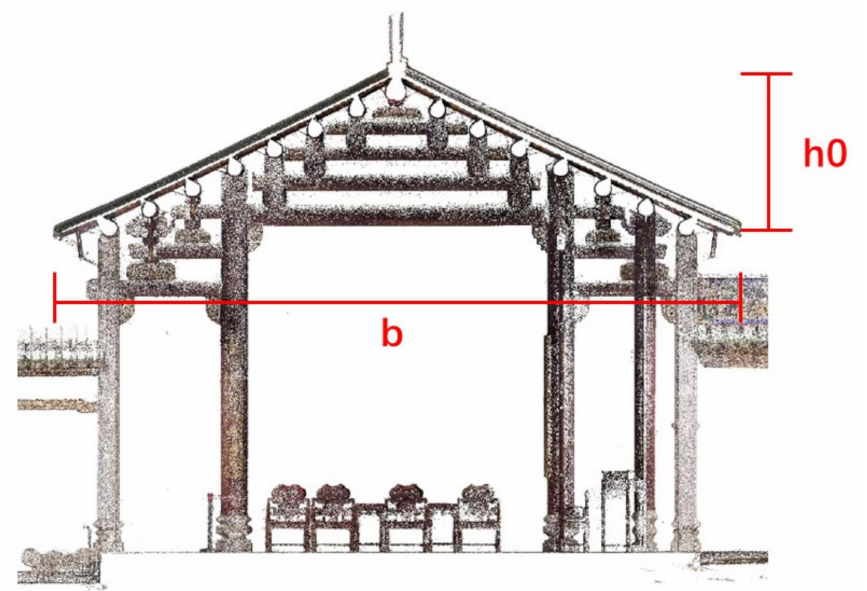
Figure 11. Method of measurement. b: distance between the front and rear eaves; h0: height of internal